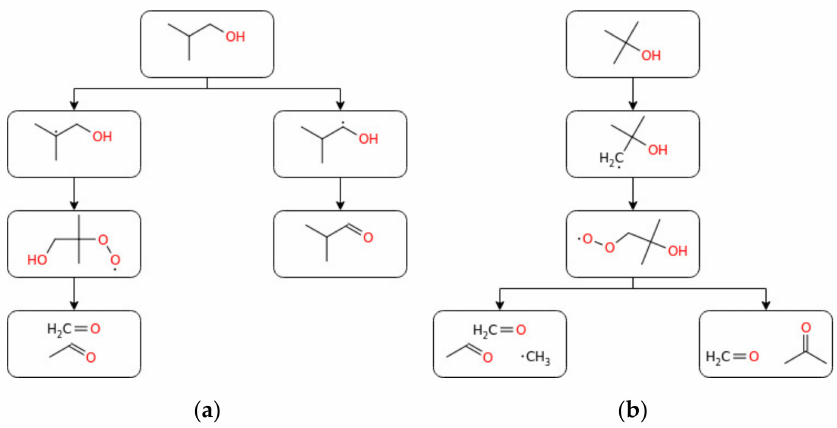
Figure 9. A simplified reaction pathway for iso-butanol ( a ) and tert-butanol ( b )